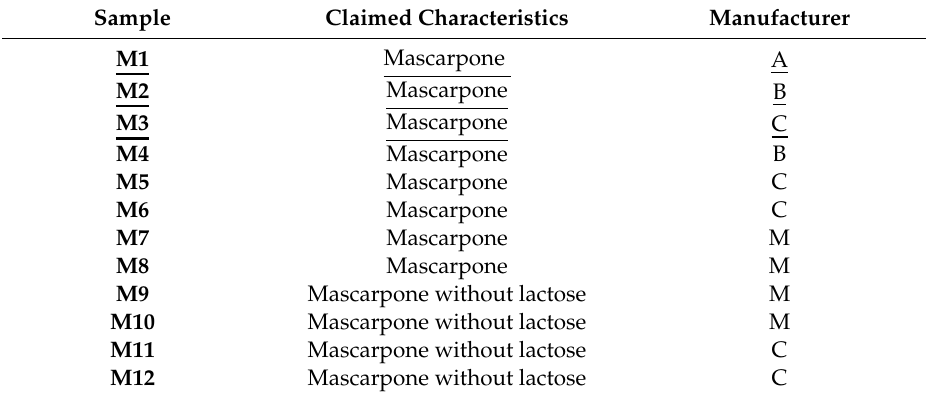
Table 1. List of commercial ‘Mascarpone’ samples analyzed in the present study. All samples (M1–M12) were investigated by PTR-ToF-MS analysis. Underlined samples (M1–M3) were evaluated also by HS-SPME GC-MS.